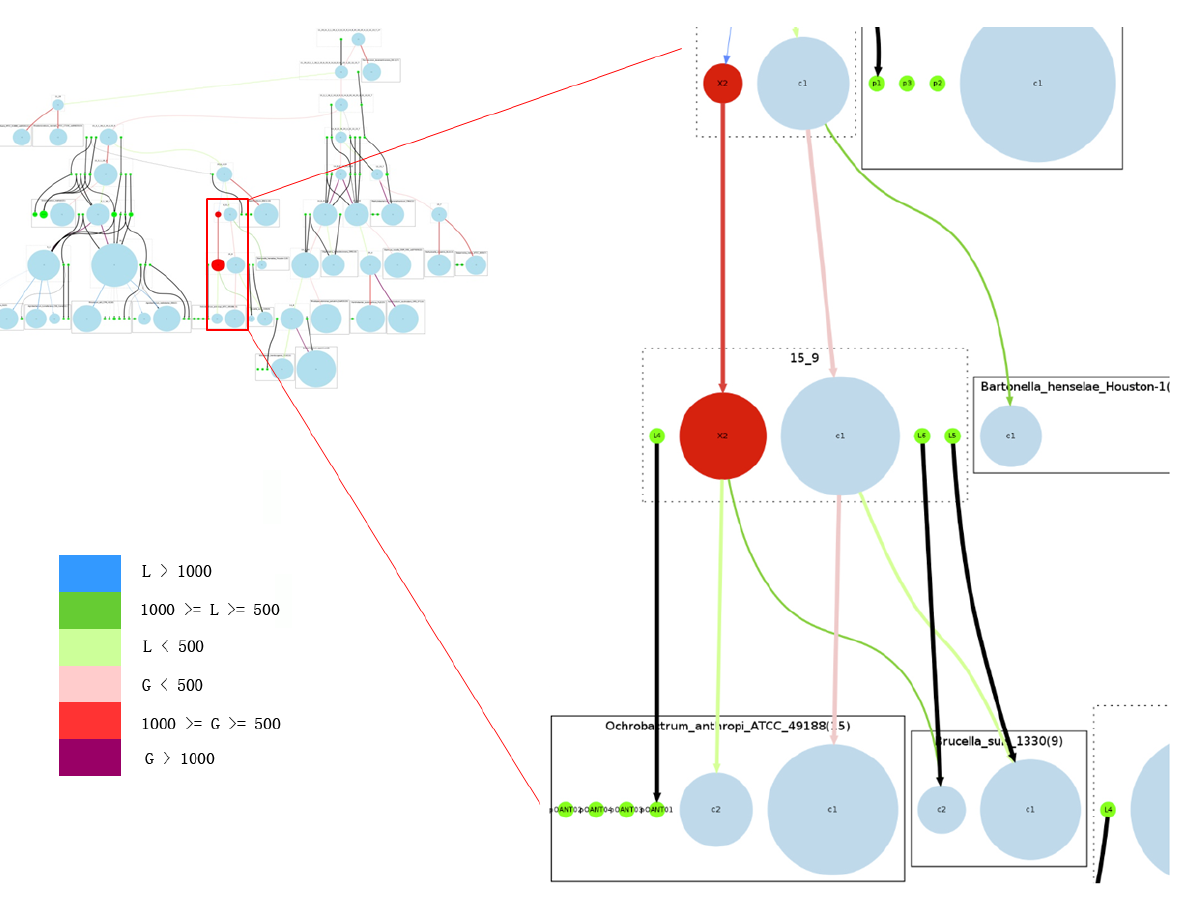
Figure 5. Overview of the complete reconstructed evolutionary history of the Rhizobiales group. Rectangles with solid edges represent input genomes and rectangles with dotted edges represent ancestral genomes. Replicons are represented as circles, with circle size proportional to replicon size (in number of genes) in the case of chromosomes; all plasmids are represented with same-sized circles. Chromosomes are shown in light blue, plasmids in green. The reconstructed secondary chromosomes are shown in red. Edge width corresponds to the strength of the inheritance relationships between replicons, and color shows the increase or decrease of chromosome sizes. Edges connected with plasmids are all marked black. On the right we provide a zoomed-in detail. Legend for color code: L : decrease in number of genes; G : increase in number of